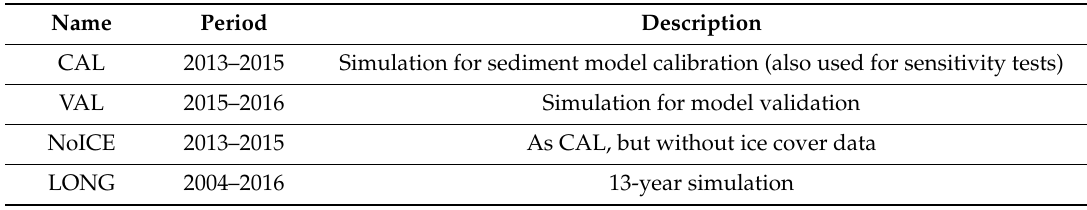
Table 3. Summary of numerical experiments carried out in this study.